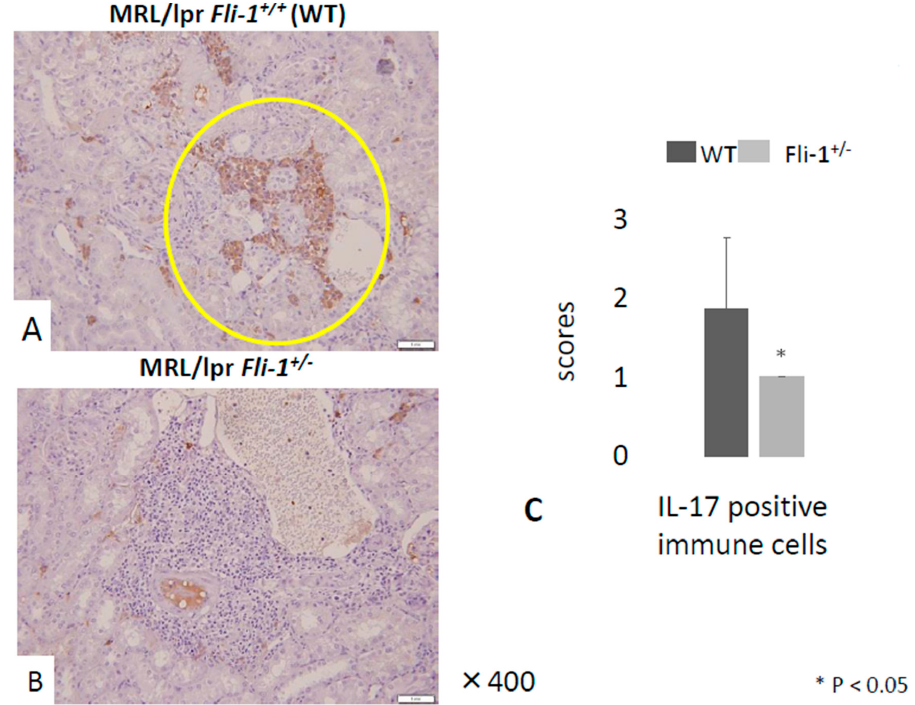
Figure 3. IL-17 staining of MRL / lpr Fli-1 +/+ (WT) and MRL / lpr Fli-1 +/ - mice. ( A , B ) Immunostaining of IL-17A in the kidney tissue from WT MRL / lpr and MRL / lpr Fli-1 +/ − mice (4 months old or older) and pathology scores in ( C ) ( n = 7–9 per groups) are shown; * p < 0.05 is considered as significant.